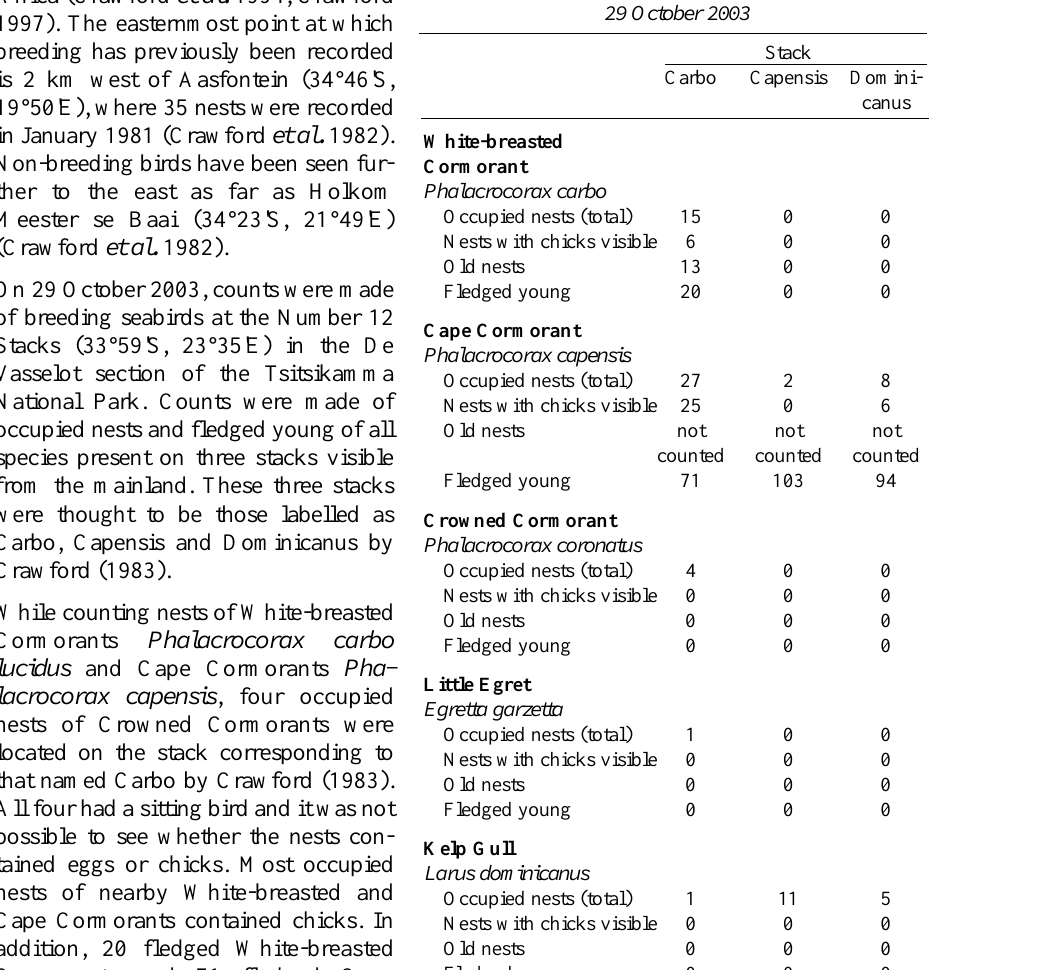
Counts of occupied nests, old nests and fledged young of all species breeding at Number 12